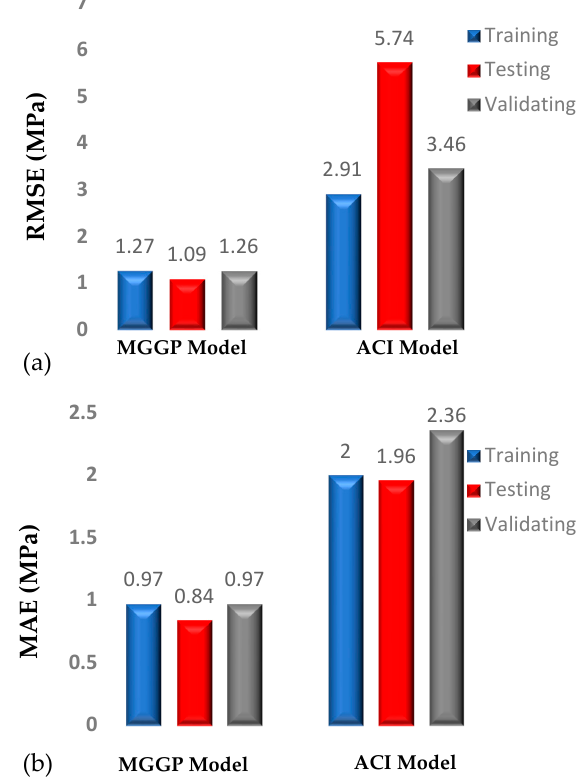
Figure 6. ( a ) RMSE of the MGGP and ACI models. ( b ) MAE of the MGGP and ACI models. A comparison of the measured and predicted bond strength by the MGGP and ACI models is shown in Figure 7. As can be seen, the proposed MGGP accurately predicts the bond strength. The ACI equation estimations are more conservative values. Figures 8 and 9 illustrate a comparison of the experimental / predicted bond strength by the MGGP and ACI models, respectively. The predictions lie above or below the target line (experimental / predicted = 1). As can be observed, the MGGP predictions are closer to the target line when compared to the ACI code equation. The averages of the experimental / predicted bond strength are equal to 1.02 and 1.19 for the MGGP and ACI models, respectively.